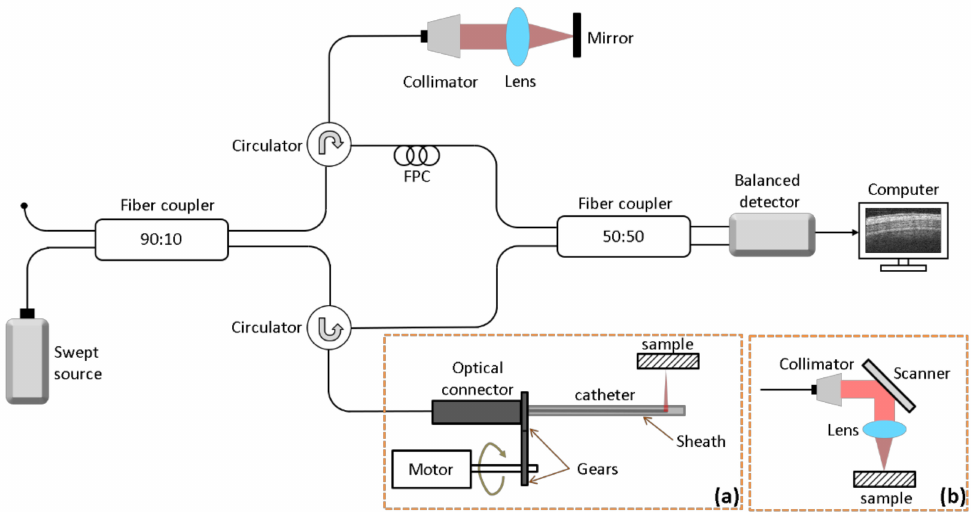
Figure 1. Schematic of the SS-OCT system setup where the sample arm is terminated with a clinical endoscopic proximal-end scanning catheter ( a ) and a conventional galvanometric scanner ( b ). FPC: fiber polarization